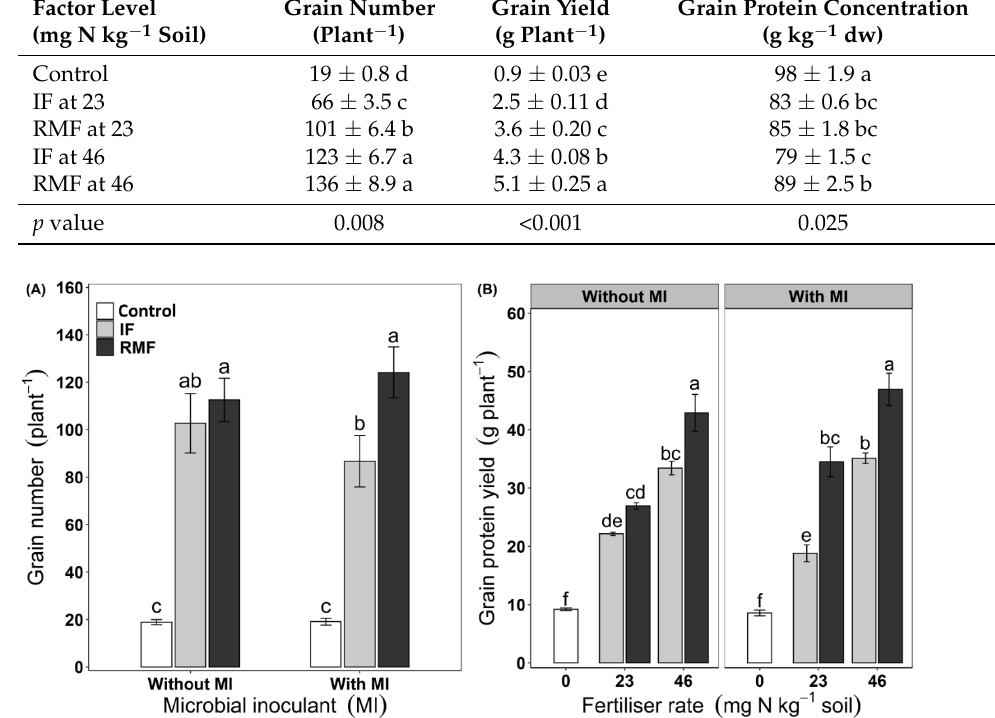
Figure 8. ( A ) Fertiliser type (Ft) × microbial inoculant (MI) (mean ± SE, n = 12) effect on grain number and ( B ) Ft × Fr (fertiliser rate) × MI (mean ± SE, n = 4) effect on grain protein yield (GPY). Means followed by the same letter are not statistically different as par Tukey’s HSD at p ≤ 0.05. Three-way ANOVA (Table 3) showed a significant interaction of Ft × MI ( p = 0.04) on grain number and Ft × Fr × MI ( p = 0.047) on GPY. Control, no fertiliser; IF, inorganic fertiliser; RMF, rock mineral fertiliser. Table 3. Analysis of variance (ANOVA) summary assessing the effects of fertiliser type (Ft), fertiliser rate (Fr), microbial inoculant (MI) and their interactions on yield components, protein concentration and yield, and root morphology of wheat. *, ** and *** denote significance at p ≤ 0.05, 0.01 and 0.001, respectively; ns, non-significant at p > 0.05. Variables